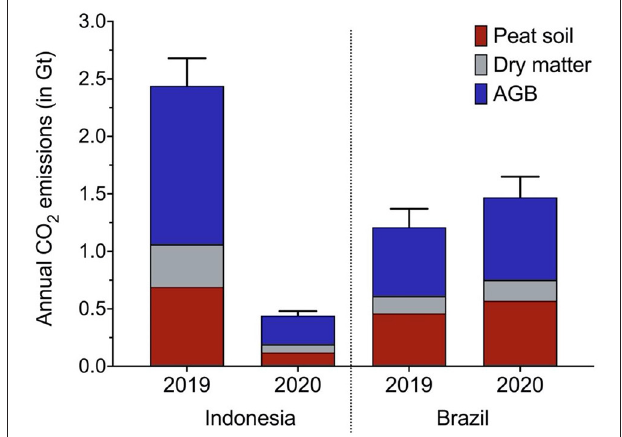
FIGURE 2 | Assessment of the annual GHG impact of deforestation fires in Indonesia, the Legal Amazon in Brazil, and the Pantanal in Brazil during 2019 and 2020. The error bars represent the cumulative uncertainty associated with the calculated GHG impact, consisting of peat soil emissions, dry matter emissions, and aboveground biomass (AGB) emissions. For peat soil emissions, the error bars are calculated based on the uncertainties reported for the average burn depth from previous fires, the associated emission factors for CO 2 , CO, and CH 4 , and the mass of burned peat. For dry matter emissions, the error bars are calculated based on the uncertainties reported for the dry matter per sq. mile. For the AGB emissions, the error bars are calculated based on the uncertainties reported in the number of trees per sq. mile, the aboveground biomass per sq. mile, and the associated carbon content. The uncertainties are reported in Table 1 and Supplementary Material